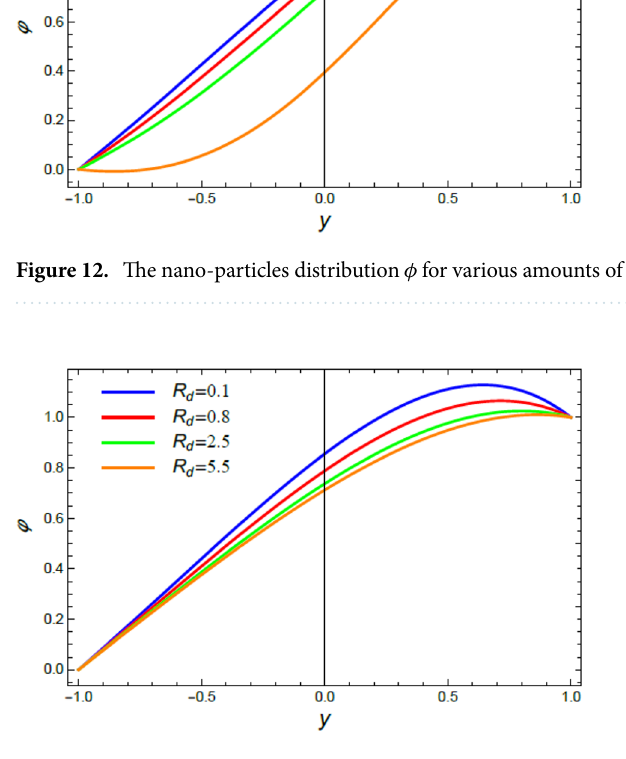
Figure 13. The nano-particles distribution φ for various amounts of the radiation parameter R d .